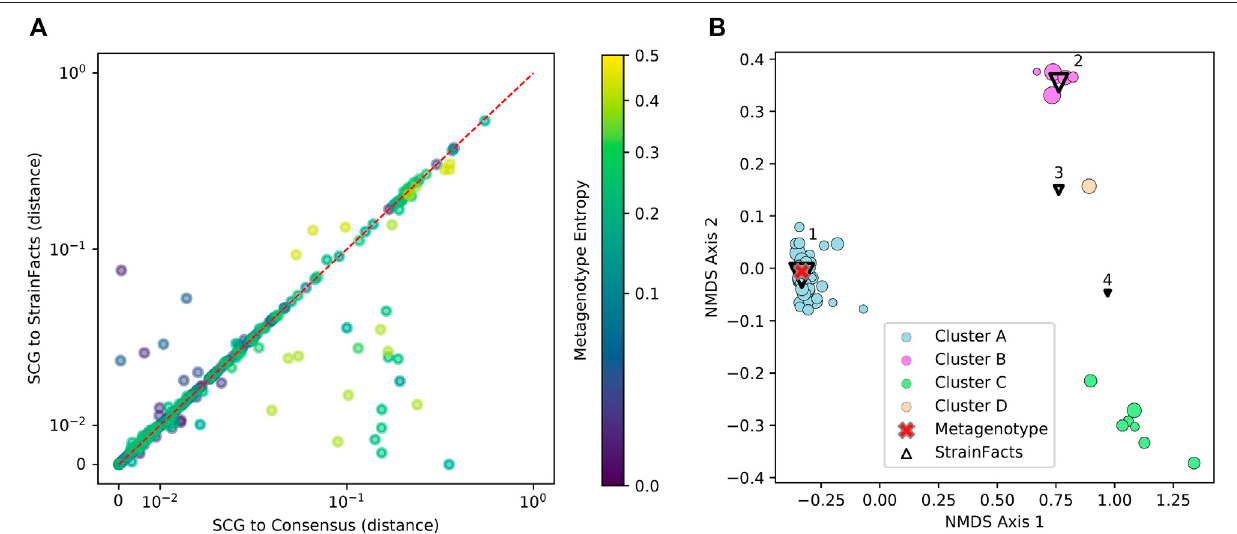
FIGURE 3 | Inferred strains re fl ect genotypes from a single-cell sequencing experiment. (A) Distance between observed SCGs and StrainFacts inferences (X-axis) versus consensus genotypes (Y-axis). Points below and to the right of the red dotted line re fl ecting an improvement of our method over the consensus, based on the normalized, best-match Hamming distance. Each dot represents an individual SCG re fl ecting a putative genotype found in the analysed samples. SCGs from all species found in either of the focal samples are represented, and marker colors re fl ect the metagenotype entropy of that species in the relevant focal sample, a proxy for the potentialstraindiversityrepresented.Axesareona “ symmetric ” logscale,withlinearplacementofvaluesbelow10 – 2 . (B) Anon-metricmultidimensionalscalingordinationof 68SCGsand inferredgenotypes for one species,S. thermophilus,withnotably high straindiversity in one ofthe two focal samples. Circles represent SCGs, are colored by theirassignmenttooneoffouridenti fi edclusters,andlargermarkersindicategreaterhorizontalcoverage.TrianglesrepresentStrainFactsgenotypesinferredtobeatgreater than 1% relative abundance, and larger markers re fl ect a higher inferred relative abundance. The red cross represents the consensus metagenotype of the focal